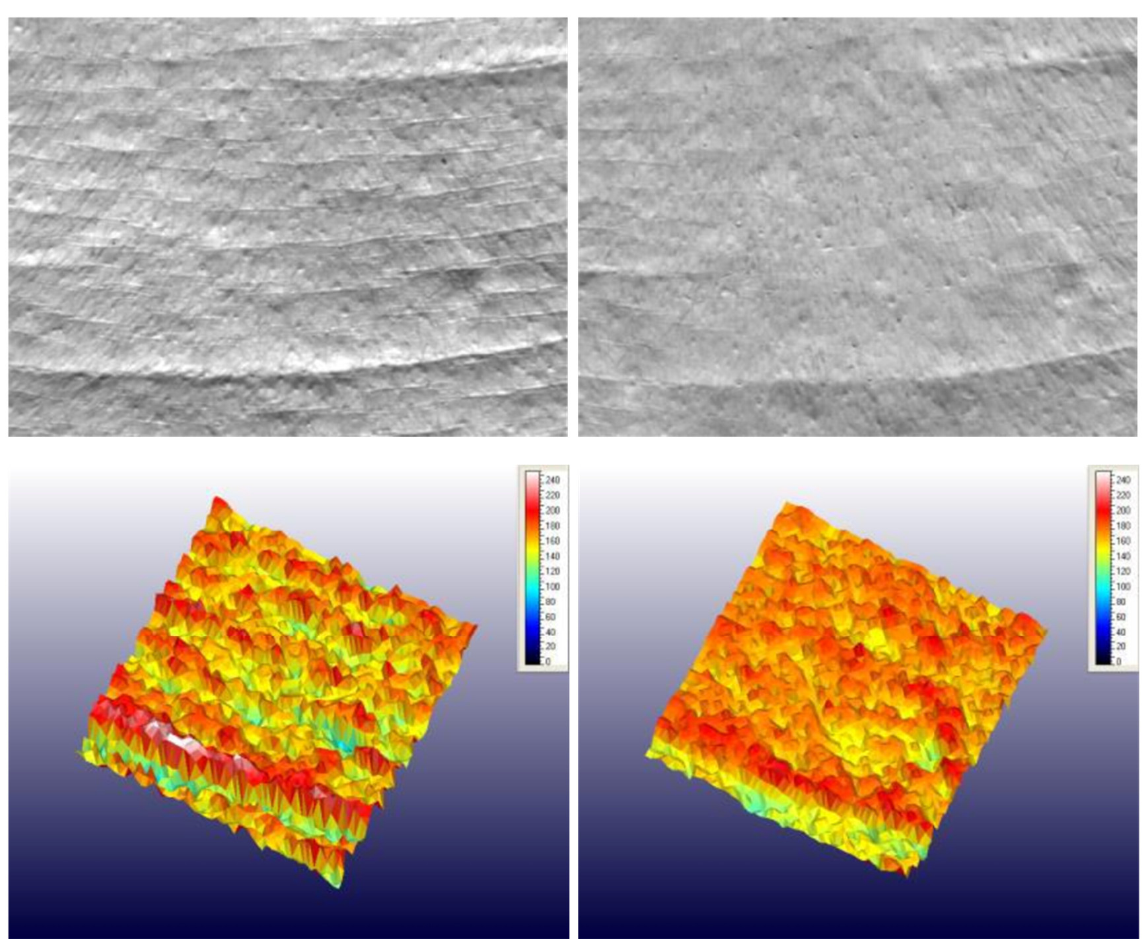
Figure 6. The images of skin texture before product application (D0) and after 28 days (D28) of regular application of an anti-ageing cream incorporating 0.5% ( w / w ) LMW-HA (20–50 KDa) and 3% ( w / w ) encapsulated HMW-HA (1–1.4 MDa) [105].